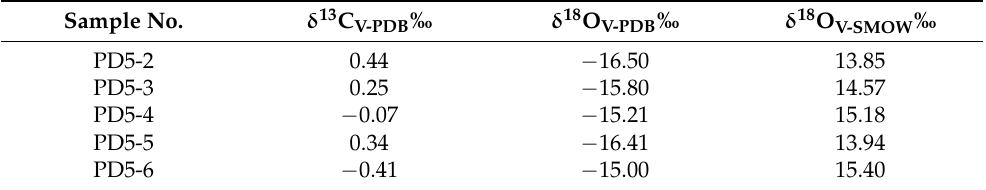
Table 2. Carbon and oxygen isotopes compositions of ore-forming calcite from the Bawang deposit (‰). Sample